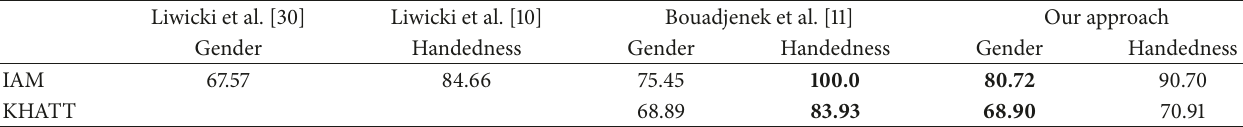
Table 9: Comparison of overall accuracy results for gender and handedness problems on Offline IAM and KHATT databases presented in related